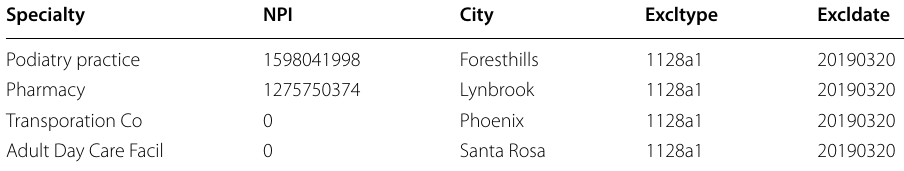
Table 2 Sample of February 2019 LEIE data